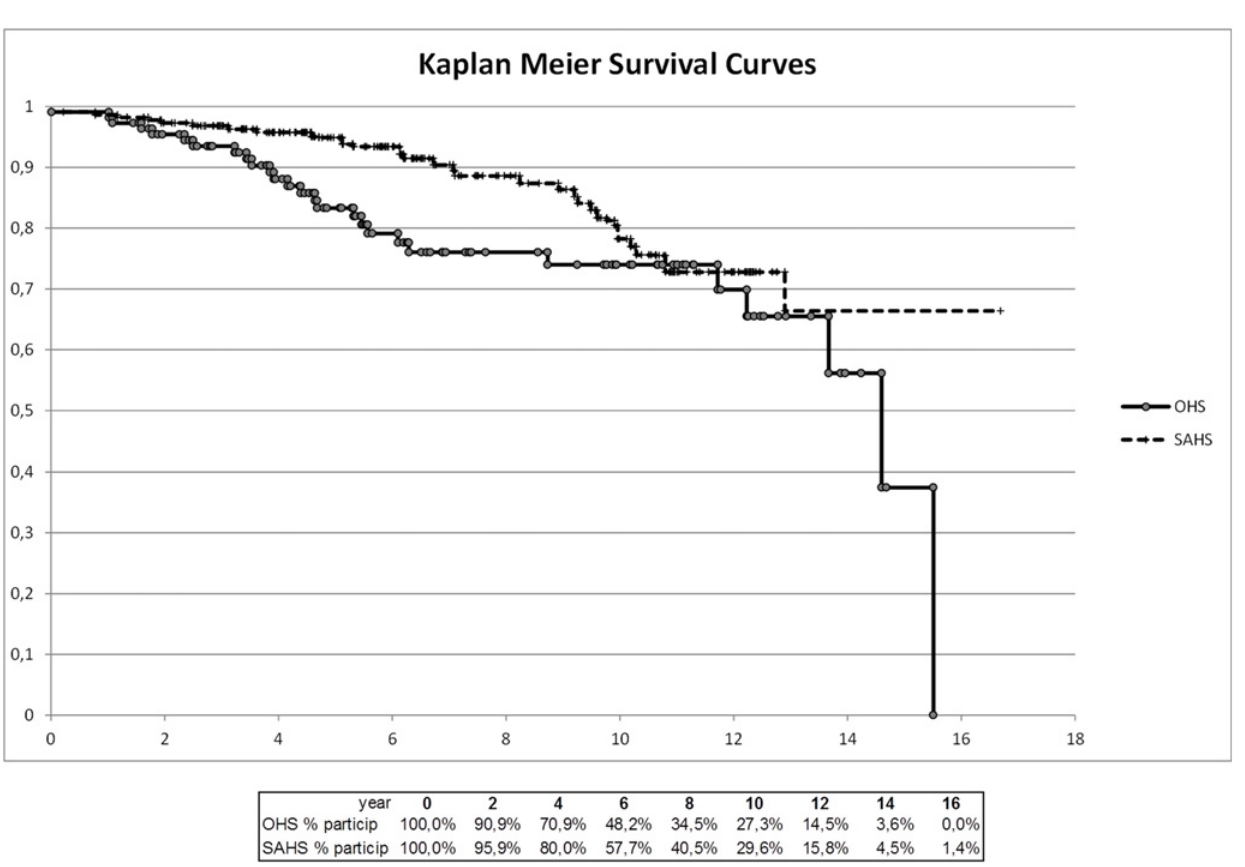
Fig 2. Kaplan-Meier survival curves for both